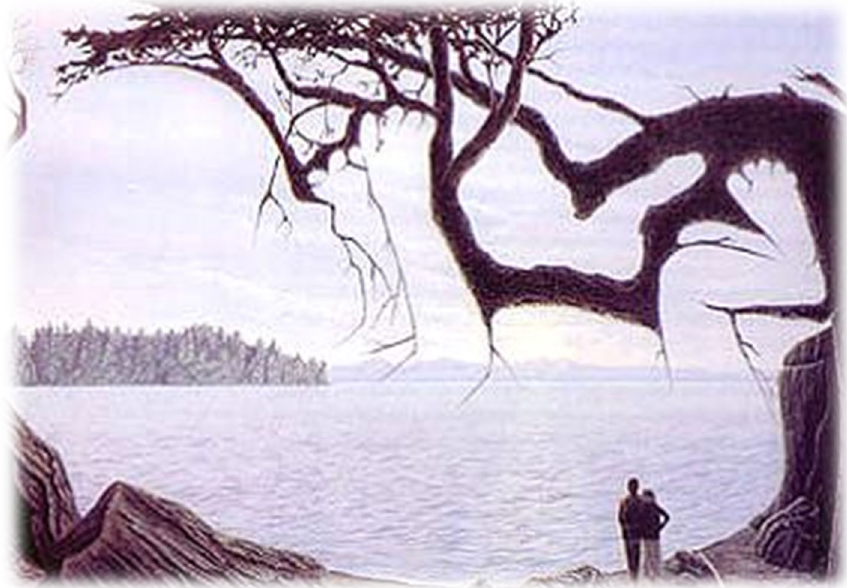
11 Figure 8. Rose, legs, couple, and shoes.